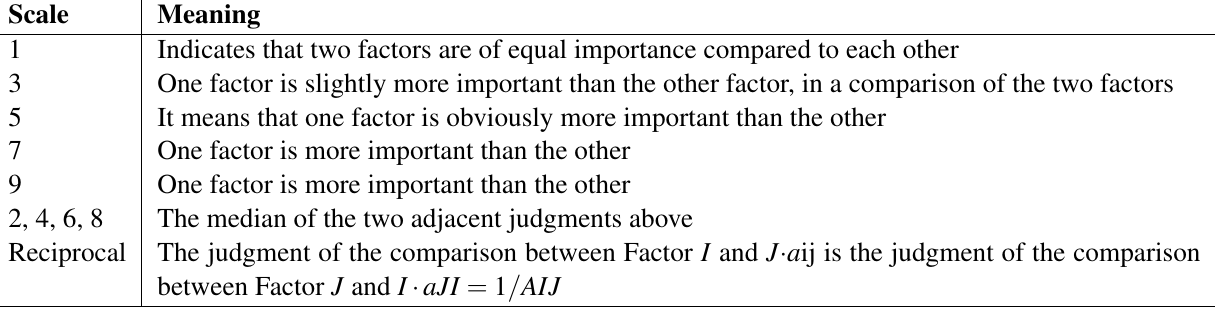
Table 1 Scaling methods for judging matrix